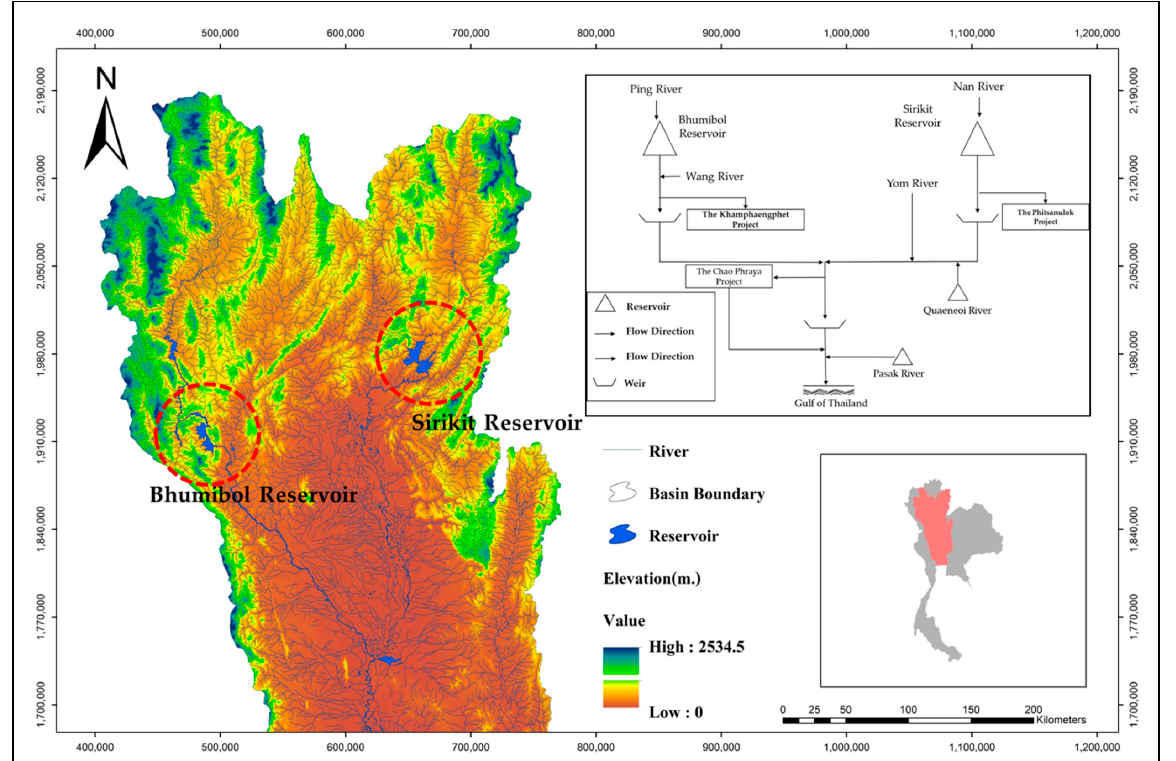
Figure 2. Locations and schematic diagram of Bhumibol and Sirikit reservoirs.